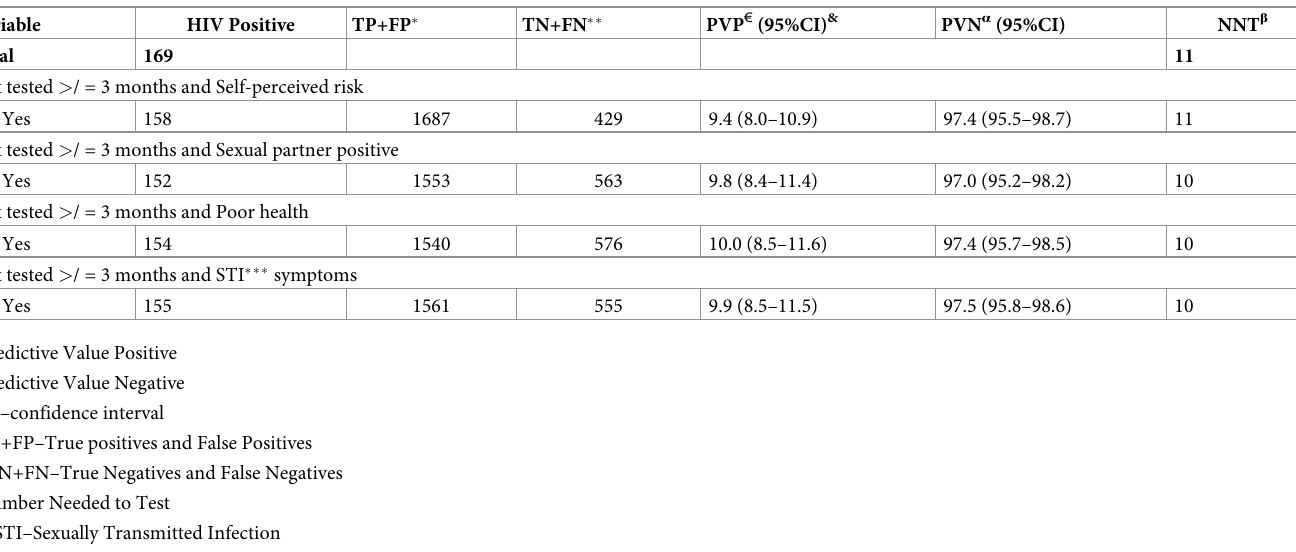
Table 9. Predictive value positive and predictive value negative for inclusion criteria combinations for HIV testing services screening questions, Zimbabwe, 2021. (N = 2116).